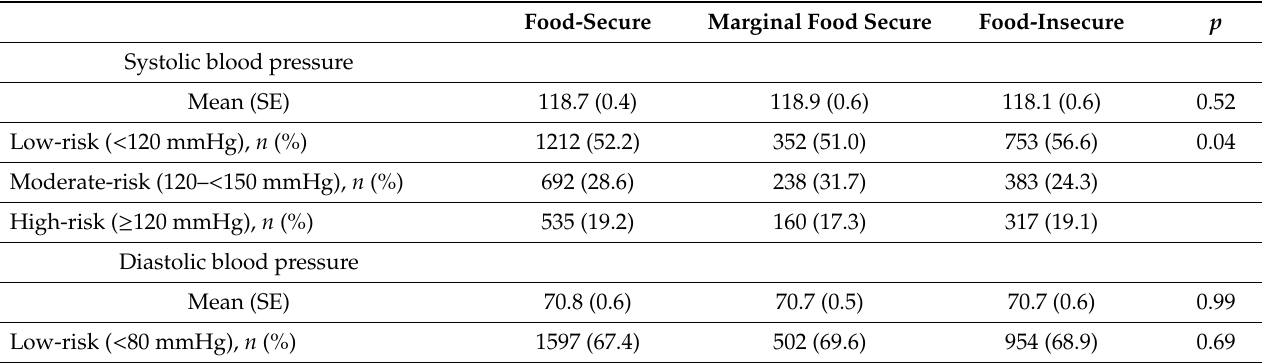
Table 2. Household food security and biomarkers of cumulative biological risk: National Health and Nutrition Examination Surveys